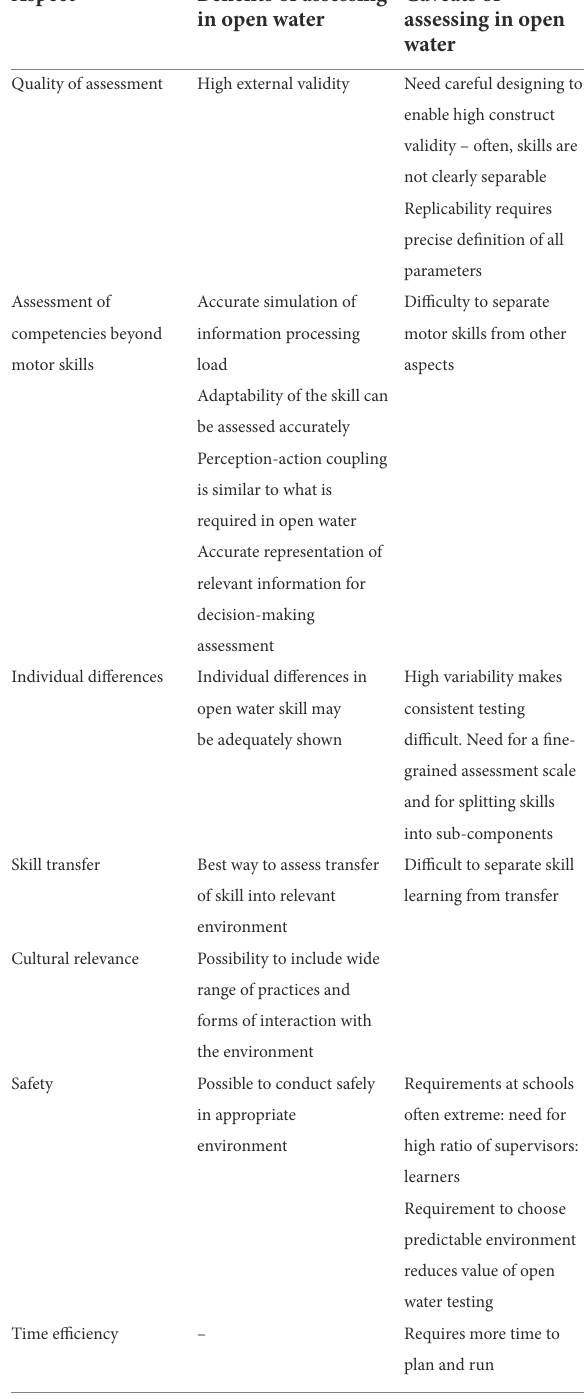
TABLE 1 Benefits and caveats of skills assessment in open